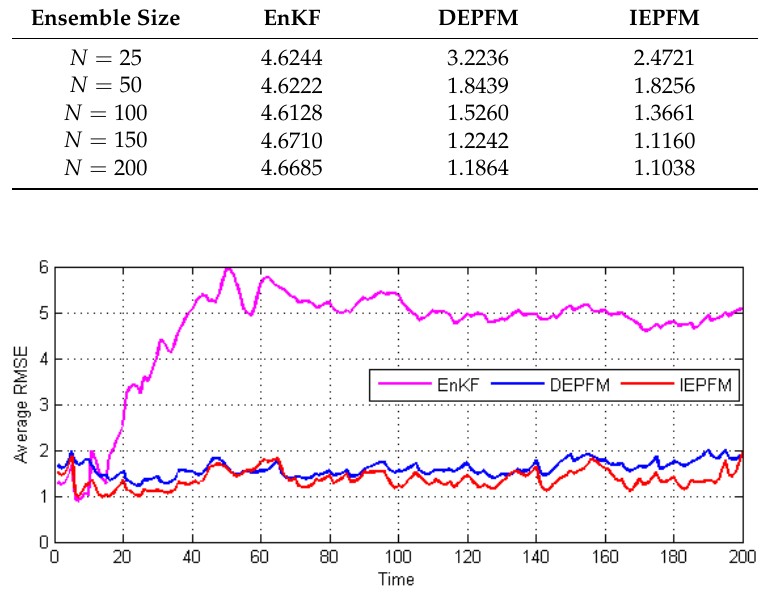
Figure 6. Comparison of the assimilation results of average RMSE at every time step.